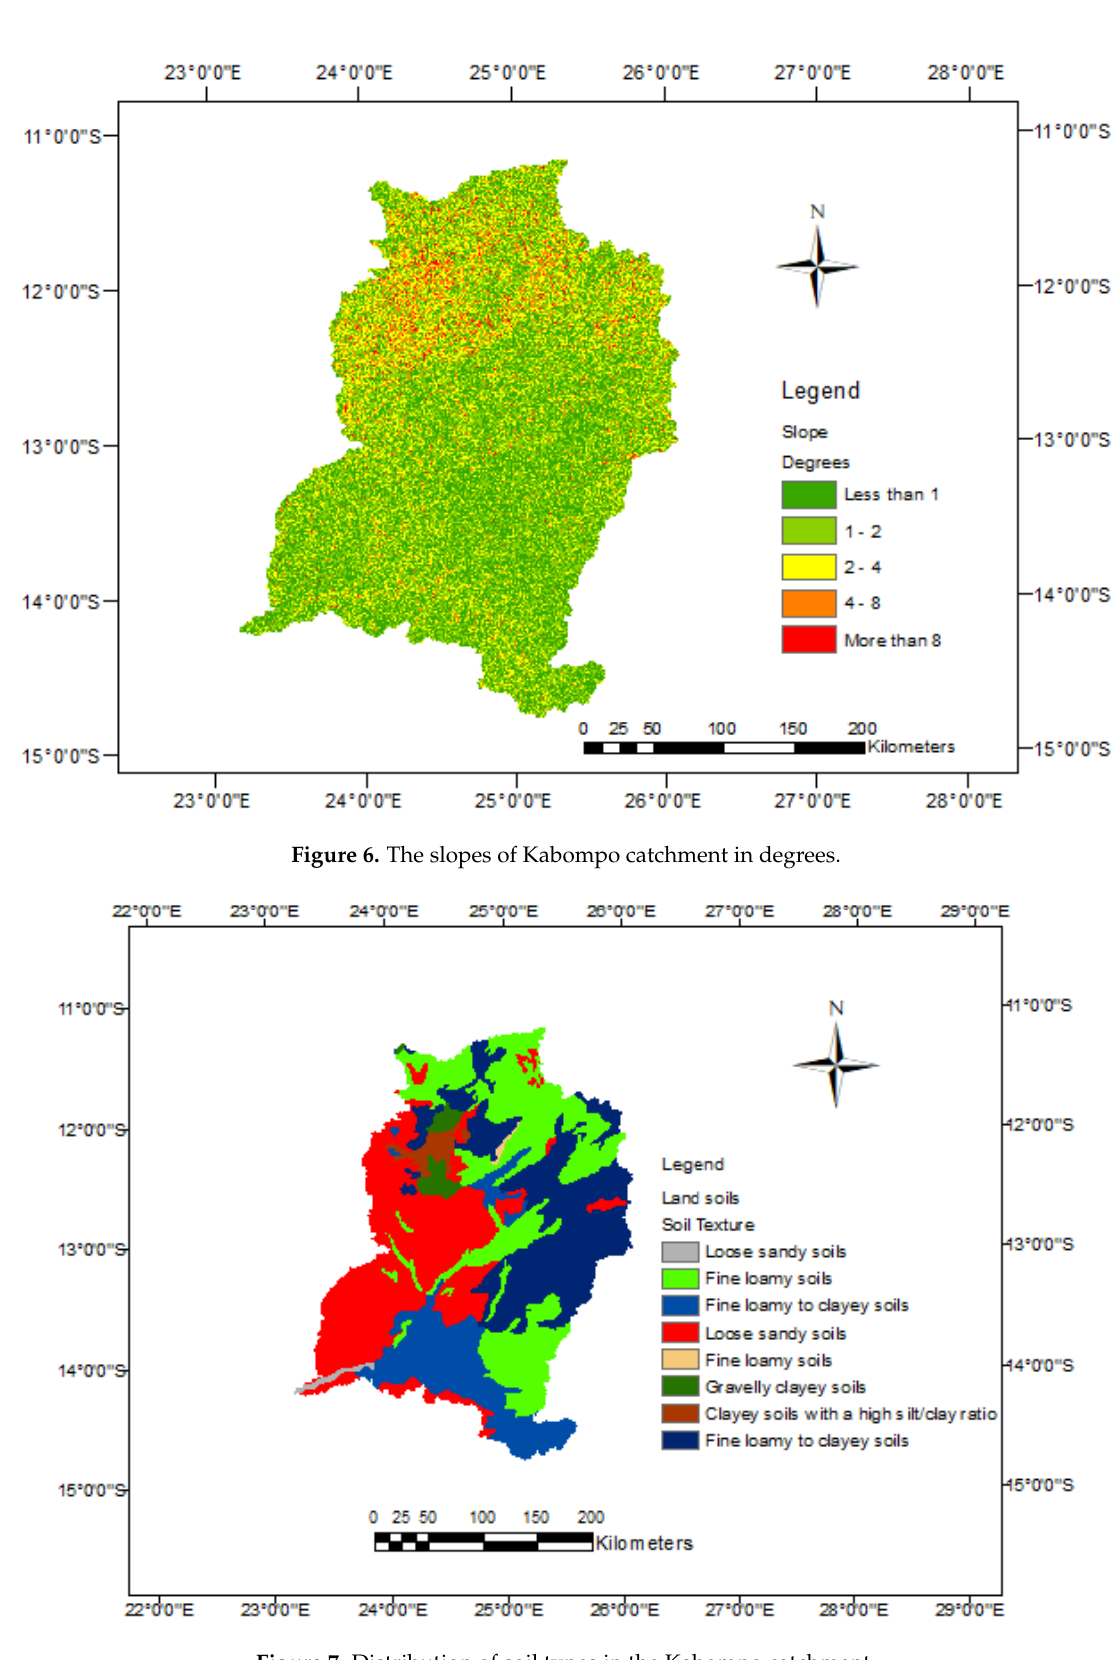
Figure 7. Distribution of soil types in the Kabompo catchment.